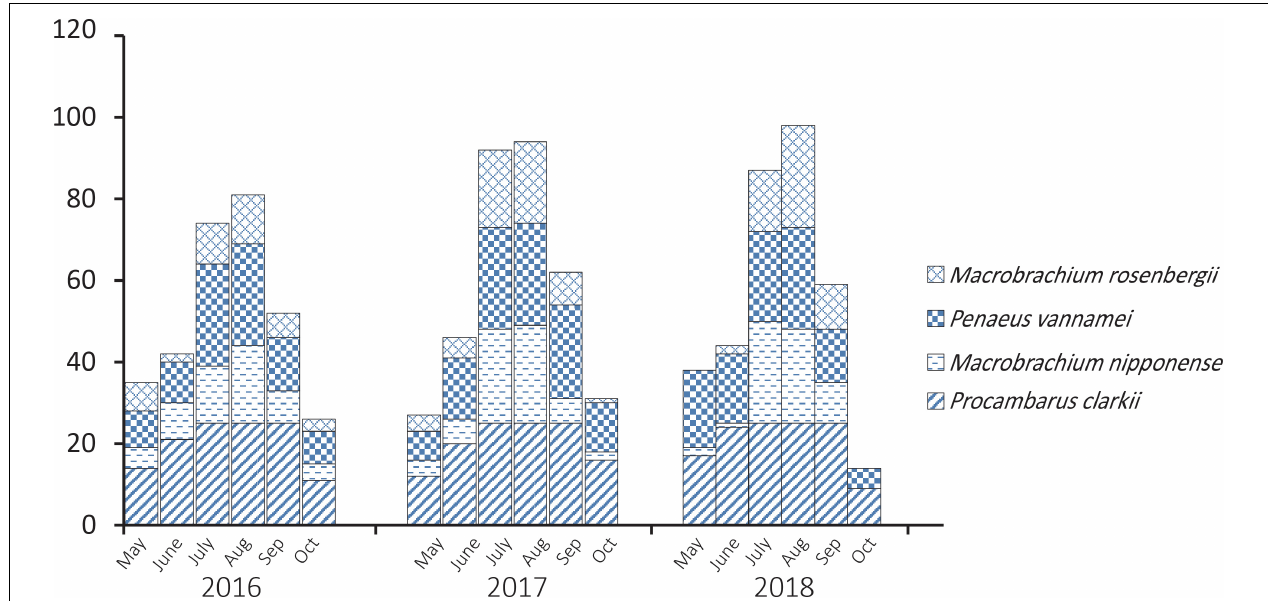
FIGURE 1 | Temporal patterns of prevalence of Vibrio parahaemolyticus isolated from aquaculture